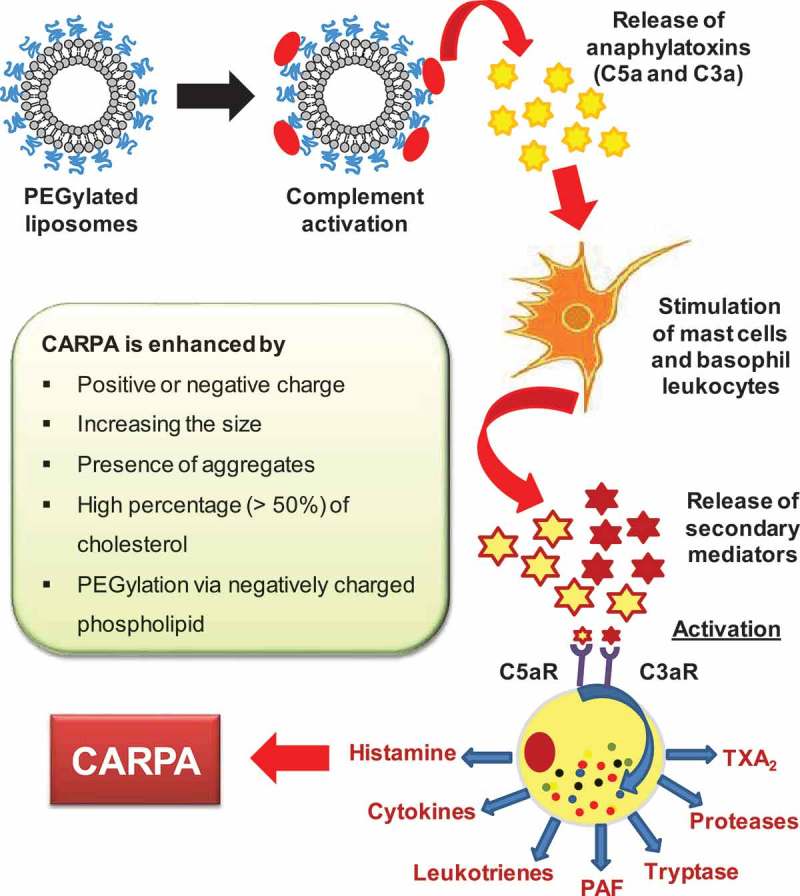
Mechanism of CARPA.